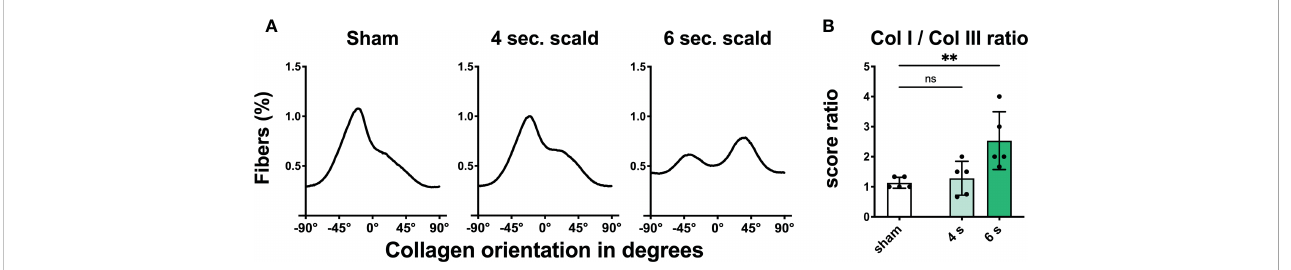
FIGURE 2 Scalding for 6 s induces reorganization and changes in composition of the dermal collagen matrix. The fraction of fi bers (A) is displayed as a function of orientation in degrees for sham, 4 s, and 6 s scald. The graphs represent the mean of all individuals of each group. The ratio of the semiquantitative scores (B) is illustrated to visualize the changes in collagen composition after thermal injury. Results are provided as mean ± SD. For comparison, one- way AVONA with Dunnett ’ s correction was performed. The levels of signi fi cance: ns, not signi fi cant; **p <